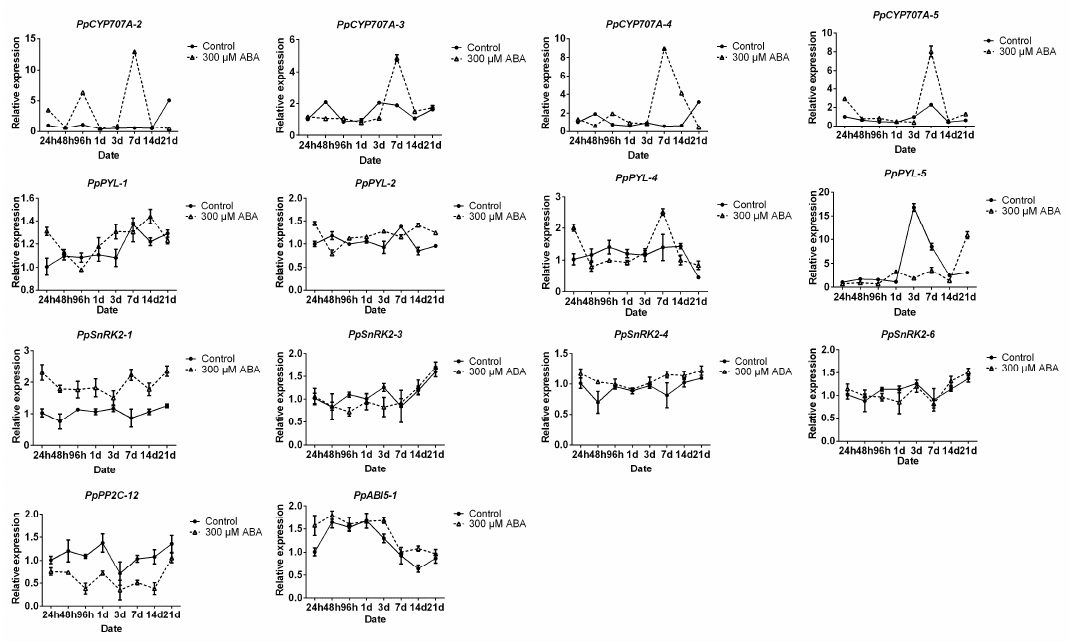
Figure 7. Exogenous ABA modulate the transcription of ABA-responsive genes. Total RNA was extracted from the control and 300-µM ABA-treated buds sampled at 24, 48, and 96 h after beginning of ABA-treatment, as well as 1, 3, 7, 14, and 21 days after treatment. Relative expression levels of ABA-responsive genes were determined by qRT-PCR as described in the Materials and Methods, and normalized against PpACTIN . The bars represent the mean ± SEM of three biological repeats.